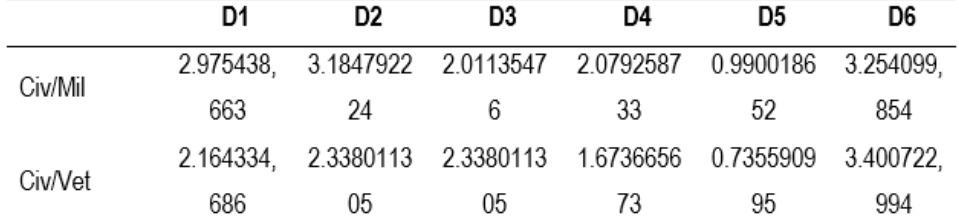
Distribution of t-values through